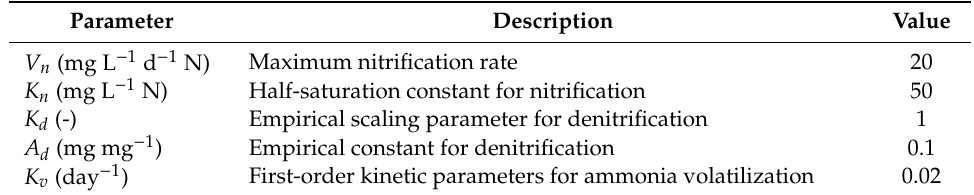
Table A3. Soil nitrogen transformation parameters used in the WHCNS model [30].